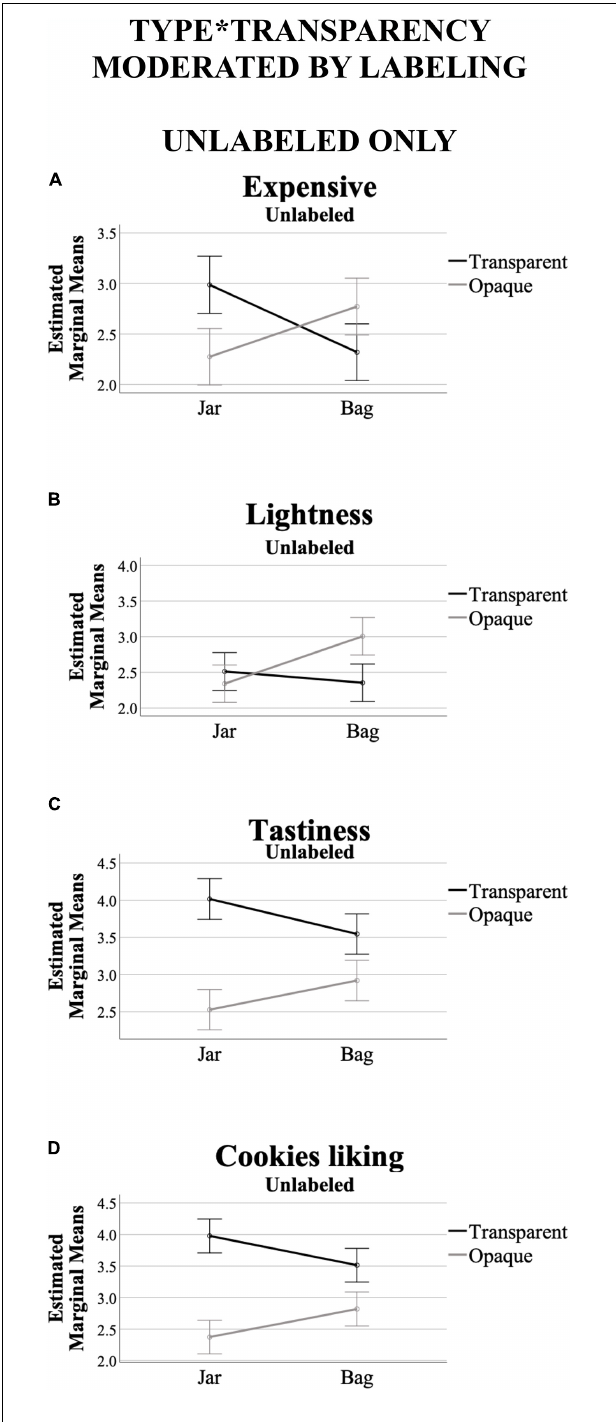
FIGURE 6 | Interaction effect of type*transparency of packaging, while moderated by labeling (labeled vs. unlabeled), across the variables that prompted significant differences at 95% confidence in “Moderating Effect of Labeling on Type*Transparency of Packaging” [only for unlabeled, (A) expensive, (B) lightness, (C) tastiness, (D) cookies liking ratings]. Y -axis are the marginal means. X -axis are packaging types. The black (darker) line corresponds to the transparent ratings, whereas the gray (clearer) line the opaque ones. Error bars show confidence interval at